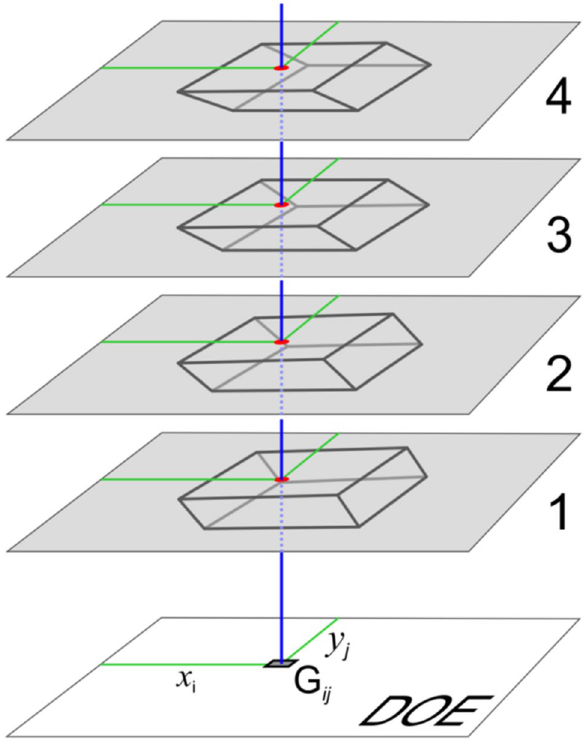
Figure 7. Schematic diagram of the formation of the angular pattern of the area G ij